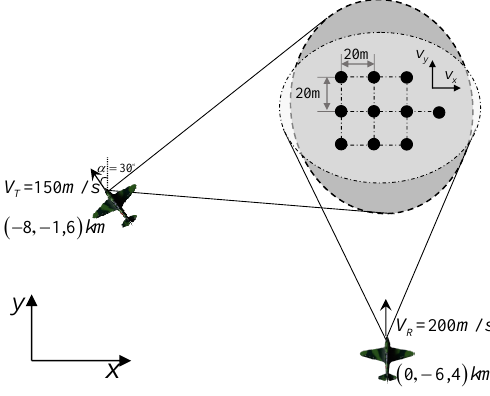
Figure 3. The original simulated moving-target